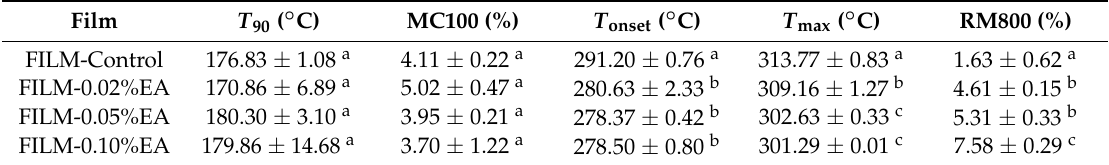
Table 3. Thermal variables determined from film thermograms of apple starch films without ellagic acid (FILM-Control) and with ellagic acid (EA) added to 0.02% (FILM-EA0.02%), 0.05% (FILM-EA0.05%) and 0.1% (FILM-EA0.1%).